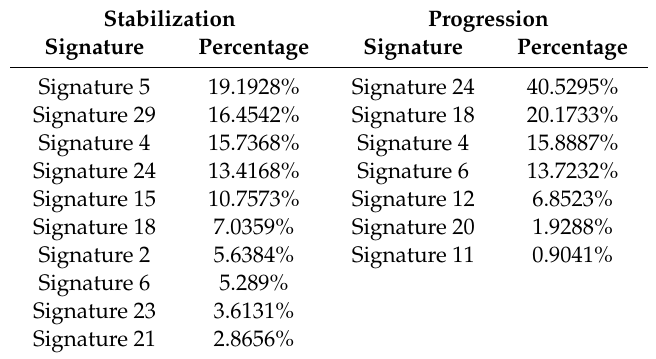
Table 2. Mutational signatures detected in both tumor samples after quantification of DNA